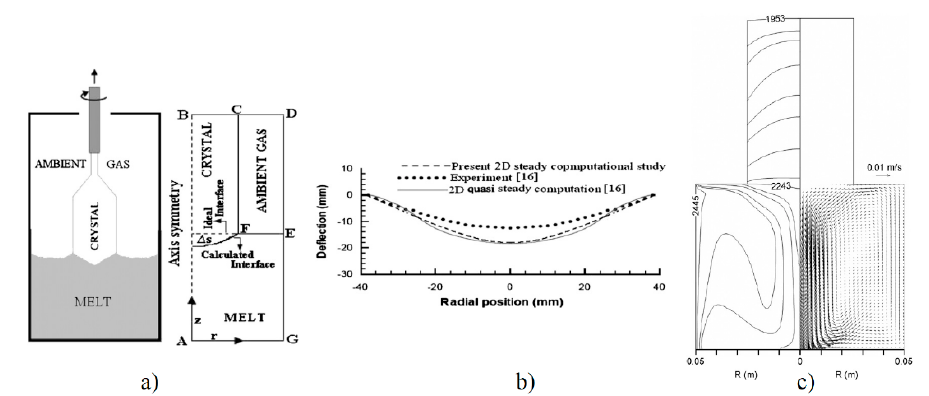
Figure 8. Optimization of the process parameters affecting the shape and position of crystal–melt interface in Cz-YAG crystal growth using feed-forward ANN/GA approach: ( a ) configuration and computational domain, ( b ) comparison of literature experimental and CFD predictions of interface deflection for InP with CFD predictions of interface deflection for YAG, ( c ) optimized temperature and velocity field. Reprinted from [18] with permission from Elsevier.